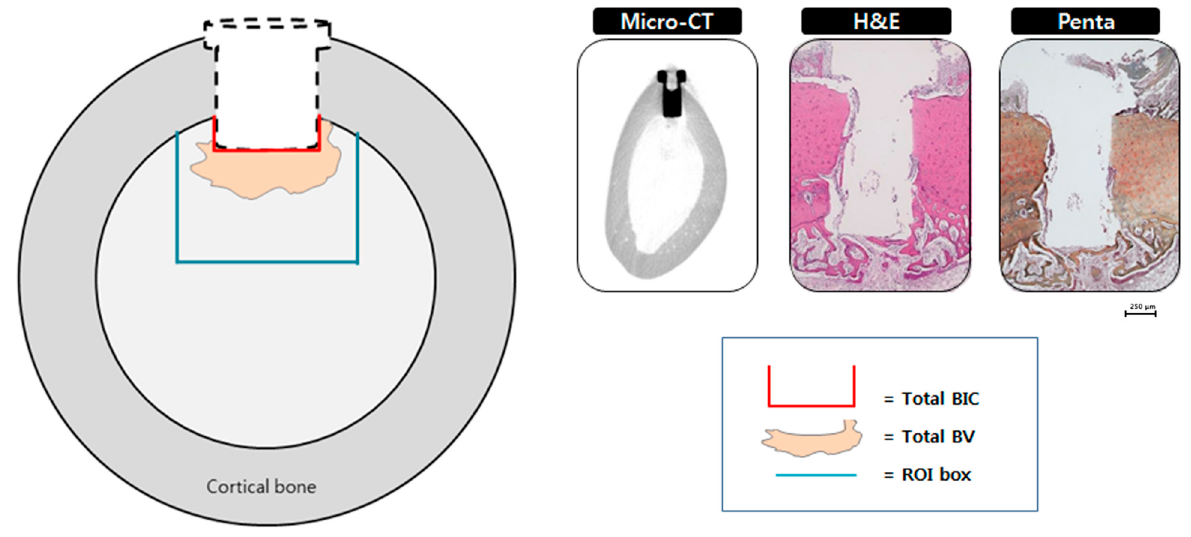
Figure 3. Method of calculating the bone-implant contact (BIC) value and newly developed bone area within the region of interest (ROI).